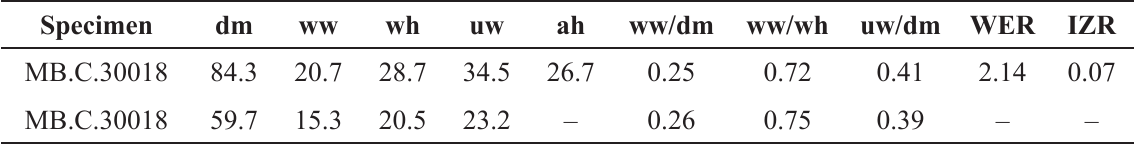
Table 29. Conch dimensions (partly estimated) and ratios of the holotype of Lutites plicatus Korn & Hairapetian gen. et sp. nov. from Baghuk